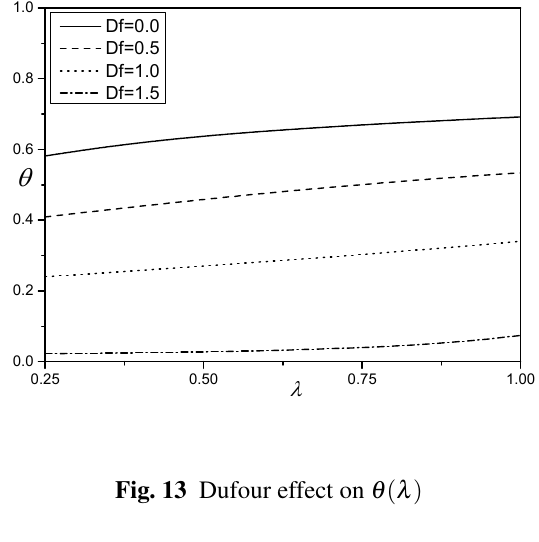
Fig. 13 Dufour effect on θ ( λ )